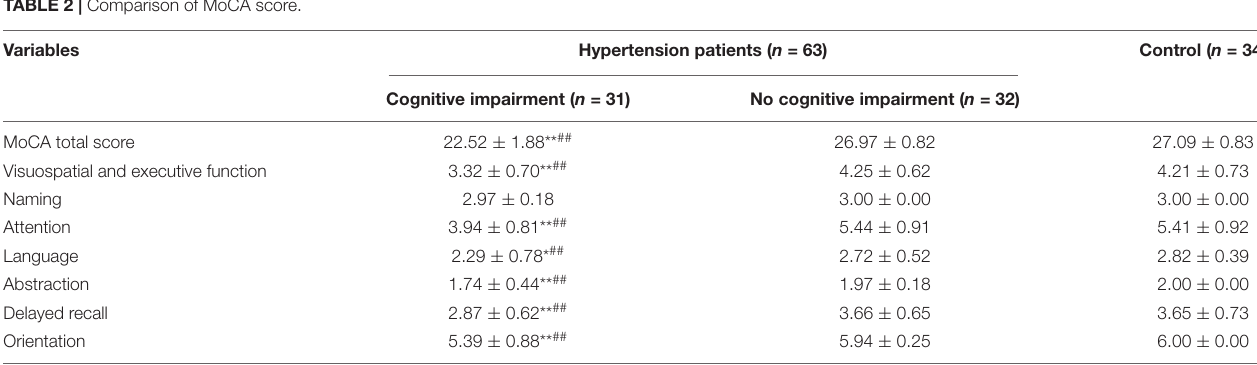
TABLE 2 | Comparison of MoCA